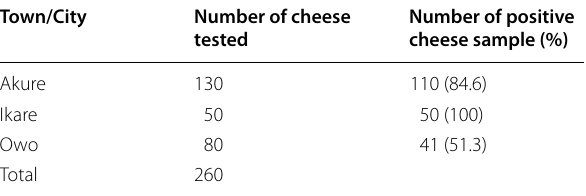
Percentage frequency (Number of positive cheese samples/Number of cheese = tested) ×